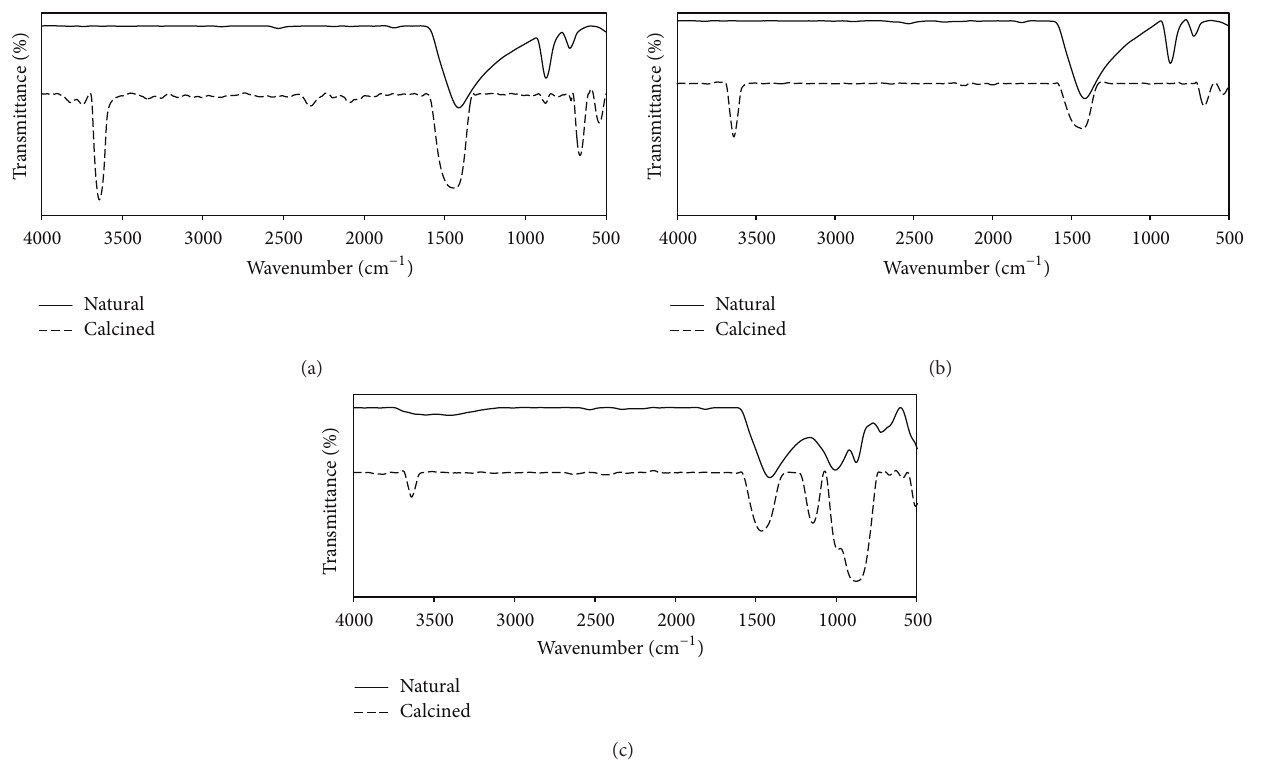
Figure 4: FTIR spectra before and after calcination (a) P1 dolomite, (b) P2 dolomite, and (c) P3